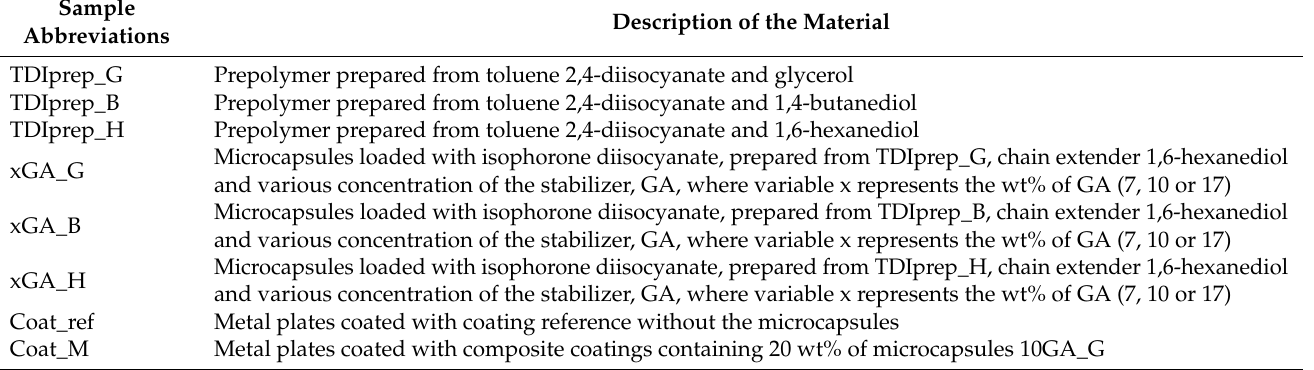
Table 1. Sample codes according to prepared